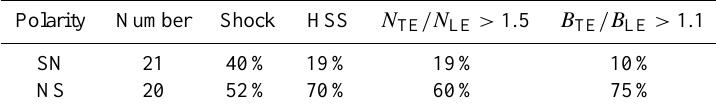
Table 4. The second (third) row gives the number of bipolar clouds that produced a stronger Dst response as SN-polarity (NS-polarity), as well as the percentages of the cases that were associated with a leading shock, increased trailing solar wind speed (HSS) and trailing density and magnetic field enhancements. For definitions, see Sect. 2.